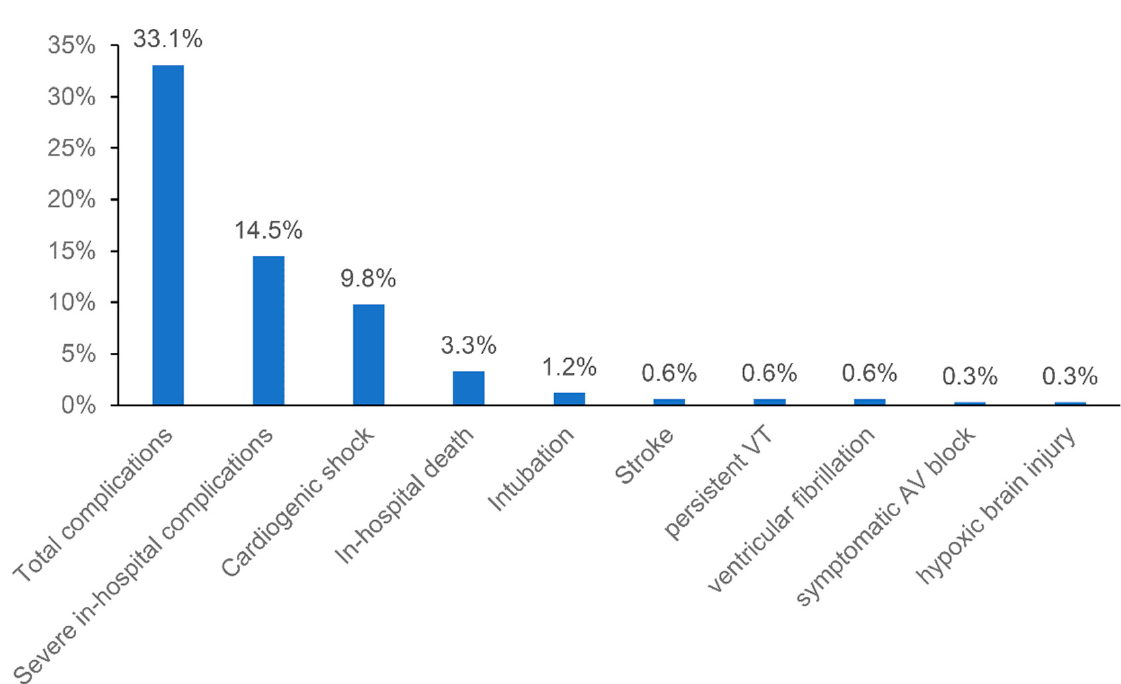
Figure 1. Total and severe in-hospital complications in the whole study population. Table 2. Total, severe and other in-hospital complications in the whole study population.